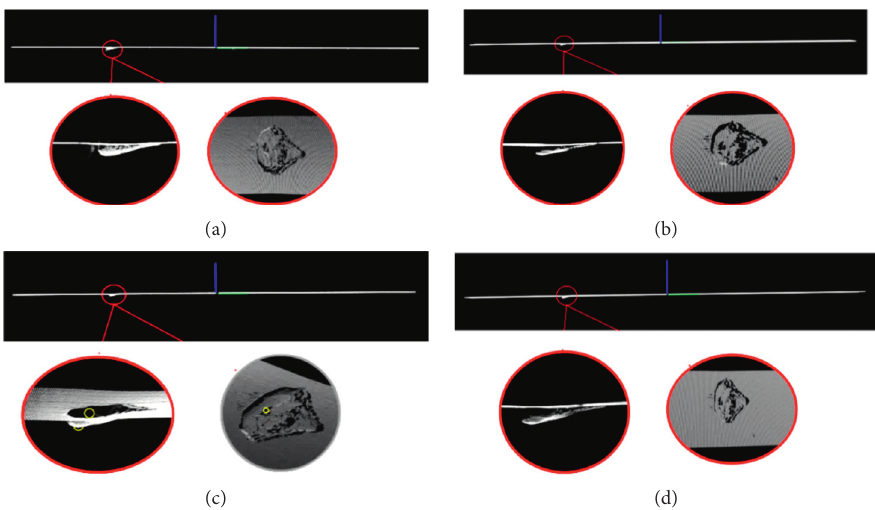
Figure 4: Denoising effect of discrete noise on the contact surface of fatigue roller with different parameters. (a) Discrete noise map of fatigue roller contact surface; (b) denoising effect picture when k � 40 and α � 1; (c) denoising effect picture when k � 20 and α � 3; and (d) denoising effect picture when k � 30 and α � 2. Table 1: Comparison of noise reduction with different K values and α values.